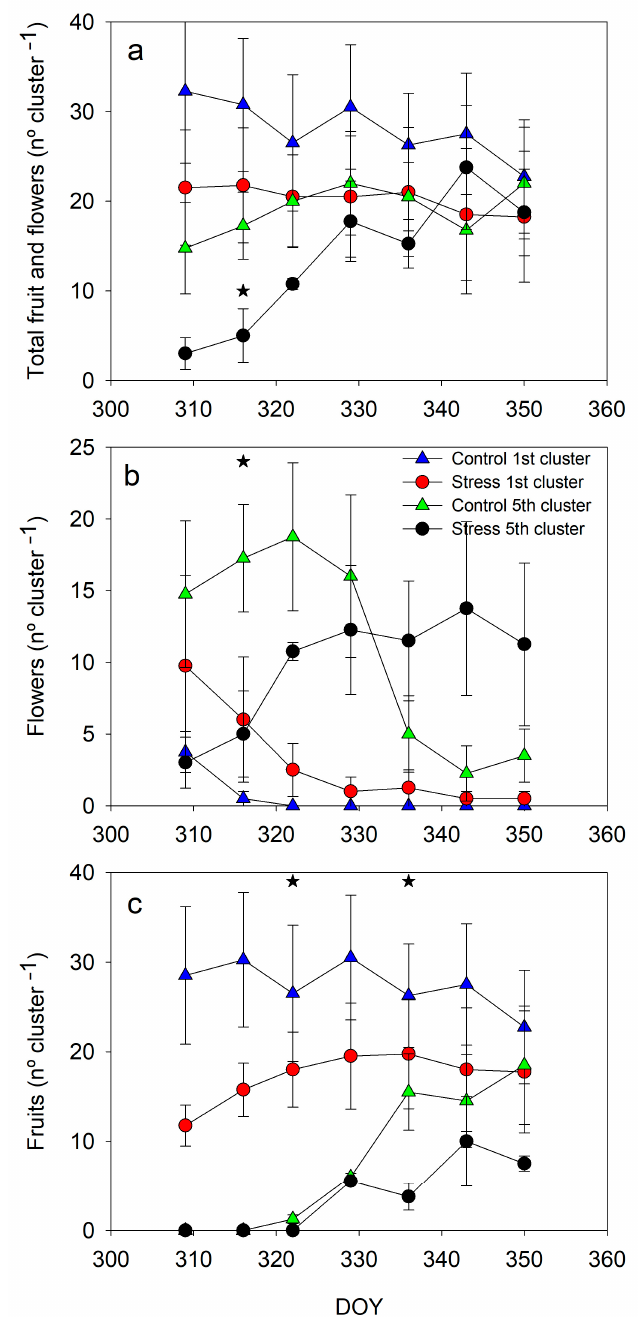
Figure 6. Pattern of fruit and flowers per cluster in the first and fifth cluster during the autumn experiment ( a ) Total fruit positions (flowers and fruits); ( b ) Total flowers ( c ) Total fruits. Each symbol is the average of 4 values. Vertical bars represent the standard error. Asterisks indicate significant differences on that date only in the fifth cluster. No significant differences were found in the first cluster ( p < 0.05).